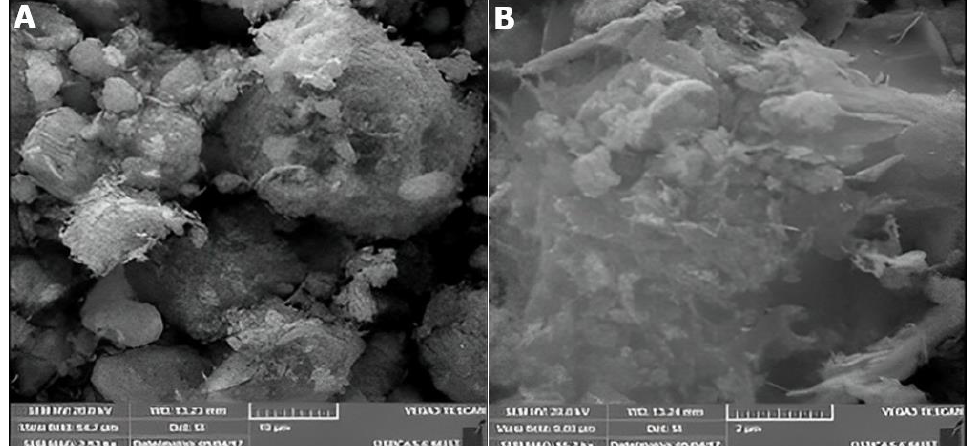
Figure 8. SEM images of fiber-like ZnO (( A )—10 µm, ( B )—2 µm) grown by hydrothermal tech- nique.